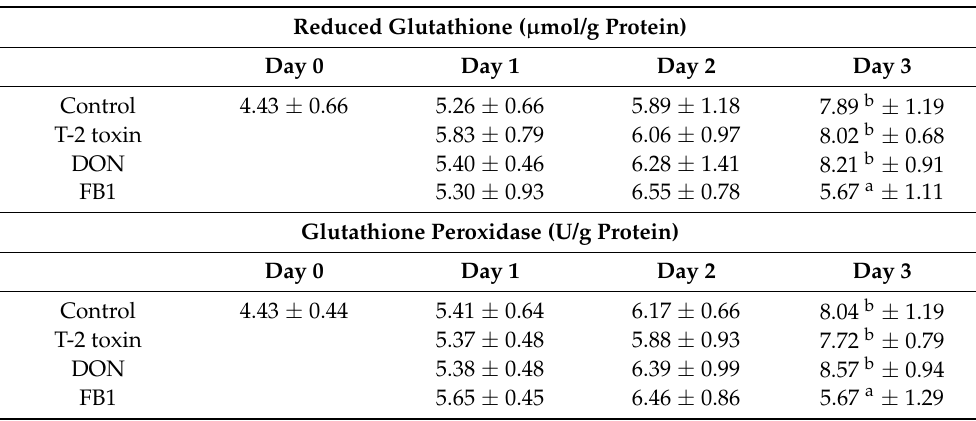
Table 6. Short-term effect of T-2 toxin, deoxynivalenol (DON), and fumonisin B 1 (FB1) treatment on the parameters of glutathione redox system in liver of laying hens (mean ± S.D.; n =